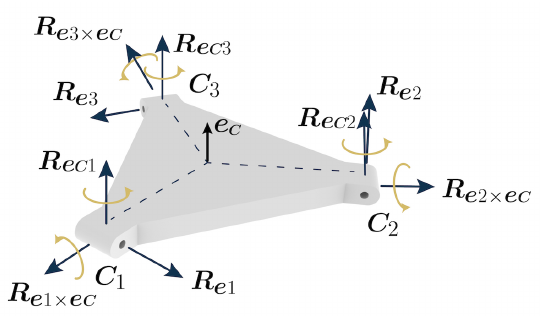
Figure A1. Constraints exerted on the upper platform by the n kinematic